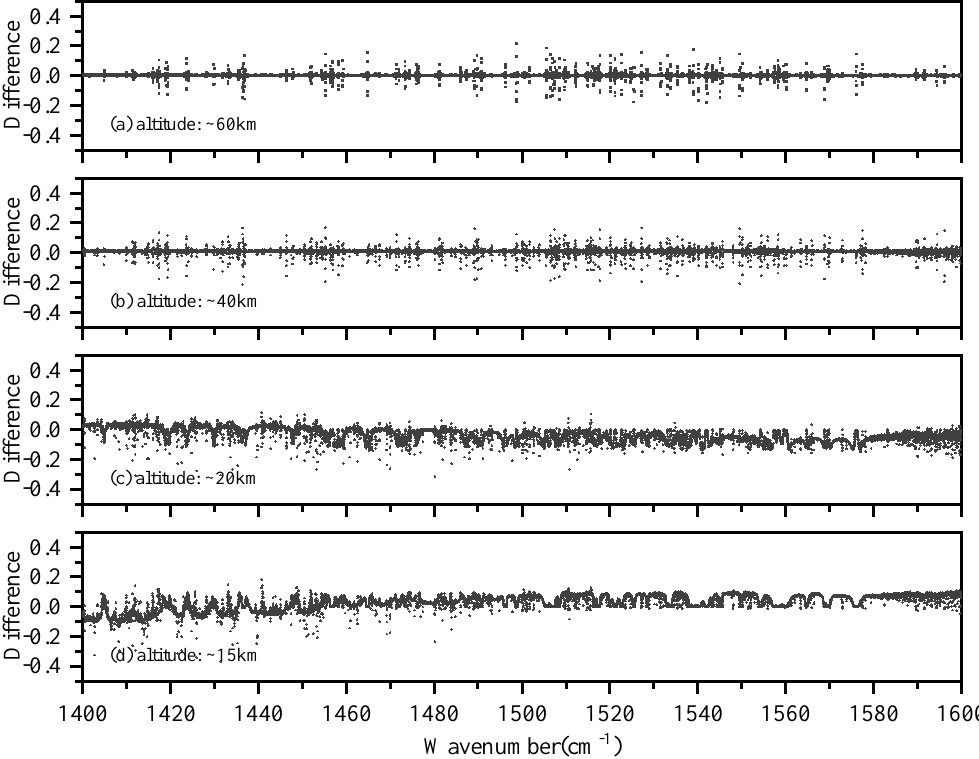
Figure 6. The transmittance differences between AIUS measurements and simulations in 1400–1600 cm − 1